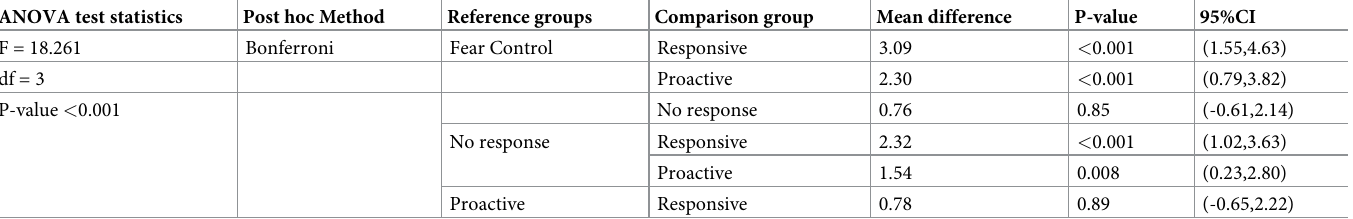
Table 7. Showing difference in mean defensive avoidance score by efficacy threat interaction (Quadrants) of patients with diabetes in JUMC, Ethiopia April 12-May 25 2020 (n = 343).